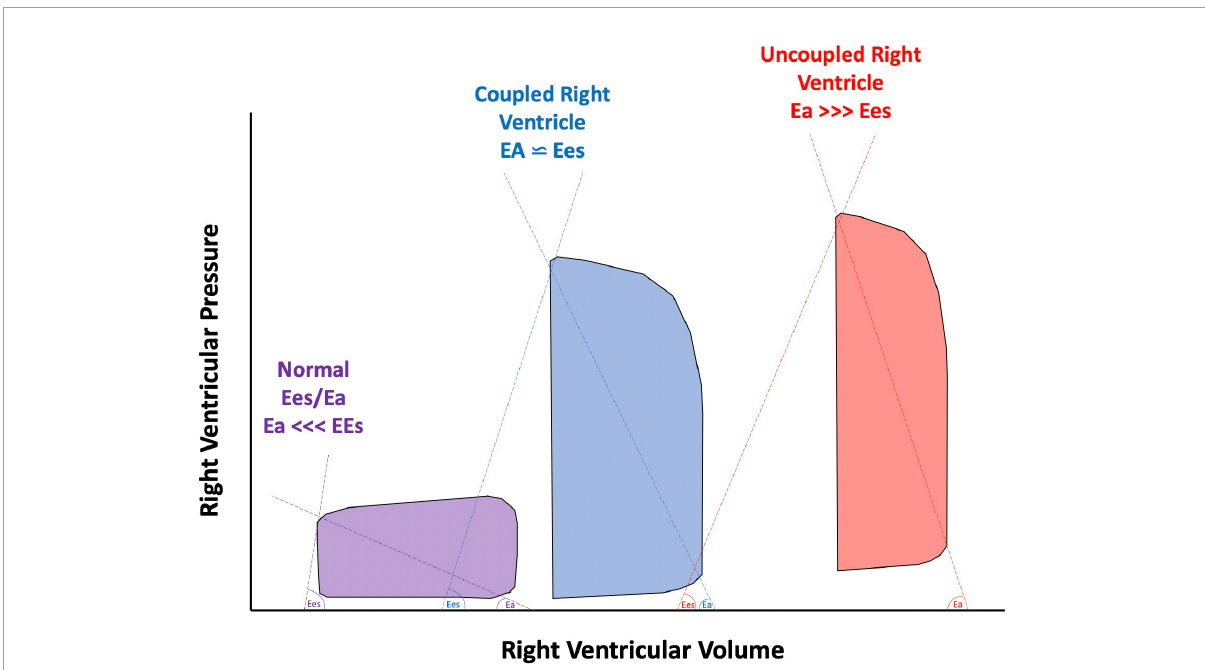
FIGURE4 Pressure volume loops of a normal right ventricle (RV) compared to a compensated, coupled RV, and uncoupled RV. Ees, end systolic elastance; Ea, effective arterial